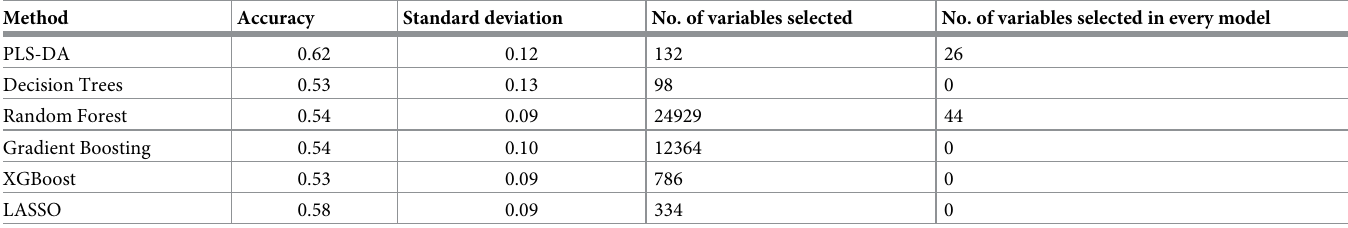
Table 3. Performance of the variable selection